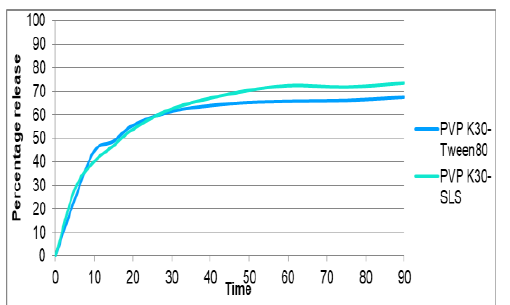
Figure 6. Influence of addition of co-stabilizer to PVP K30 on release profile in phosphate buffer (pH 6.8 ) and 37  C